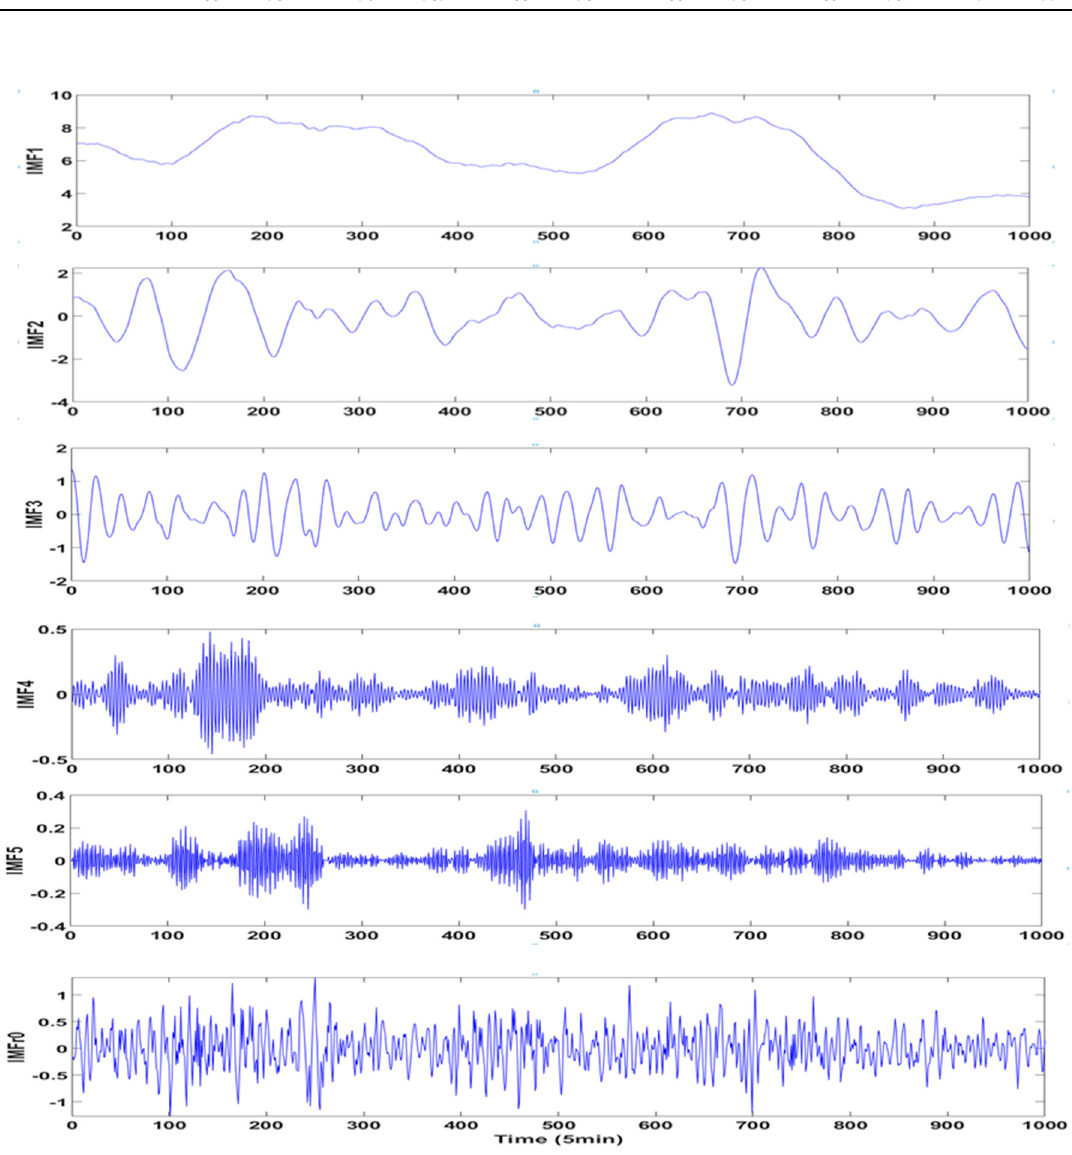
Figure 4. The waveforms of components and residual terms decomposed by variational mode decomposition (VMD).